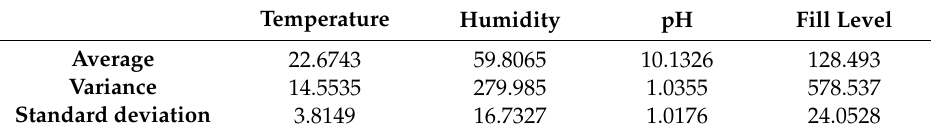
Table 8. Characterization of variables: Scenario 3 (14:00–02:00) 4